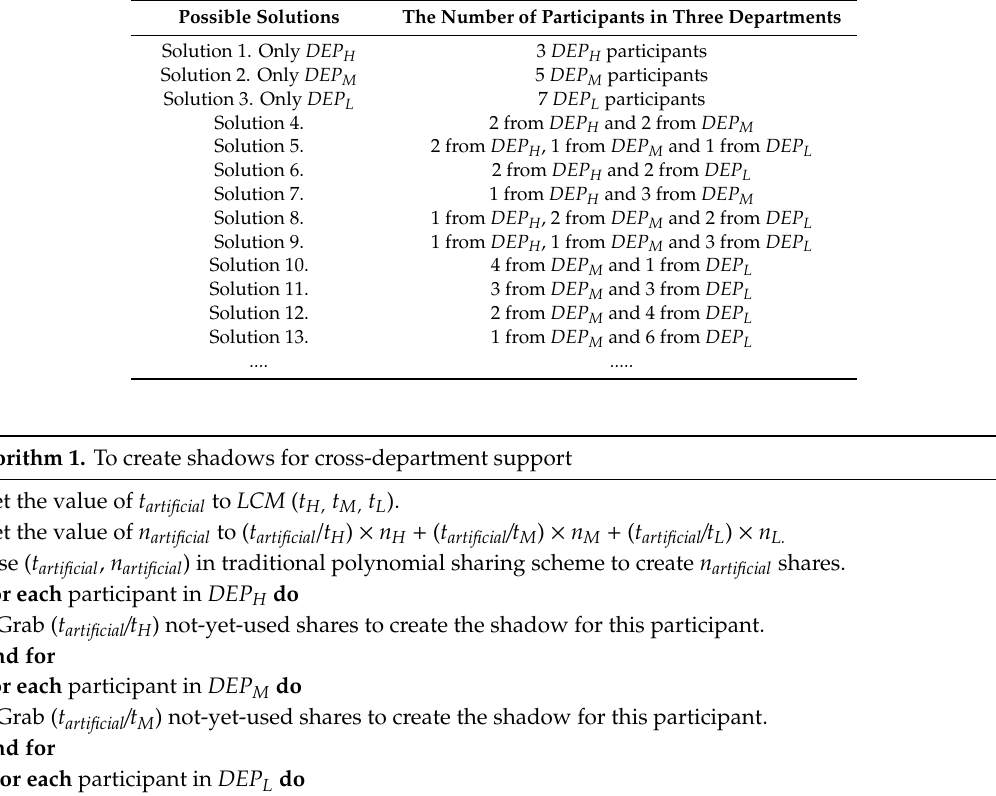
Table 2. Solutions to unveil secret using within-department or cross-department support. The ( t , n ) instances are ( 3, 4 ), ( 5, 6 ), and ( 7, 7 ), respectively, for each of the 3 departments.